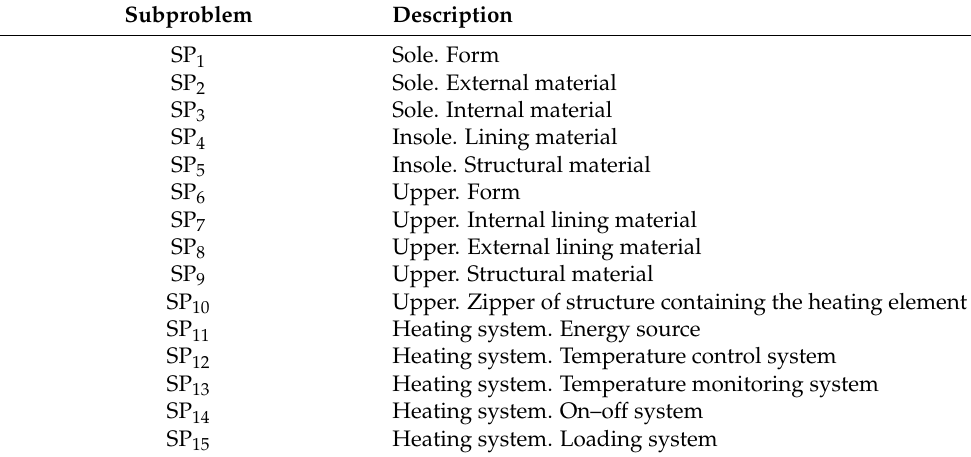
Table 10. Subproblems associated with products